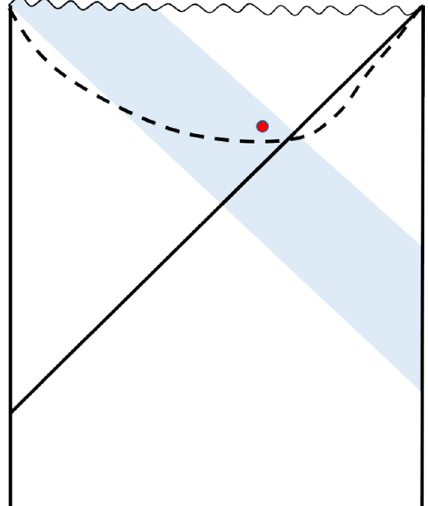
Figure 18 . The covariant bulge surface at early times (i.e. for the ‘forwards’ sweep) lies inside the infalling matter that forms the black hole. It lies a Planckian radial distance inside the apparent horizon (dashed line), at an infalling time when the apparent horizon is itself a Planckian radial dis- tance inside the event horizon (solid line). Its generalized entropy is approximately A 0 = 4 G N + S rad .